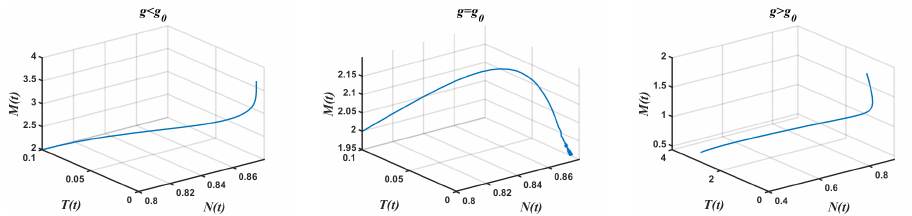
Figure 3. Parametric solutions of model (1) for various g -values corresponding to Figure 2.